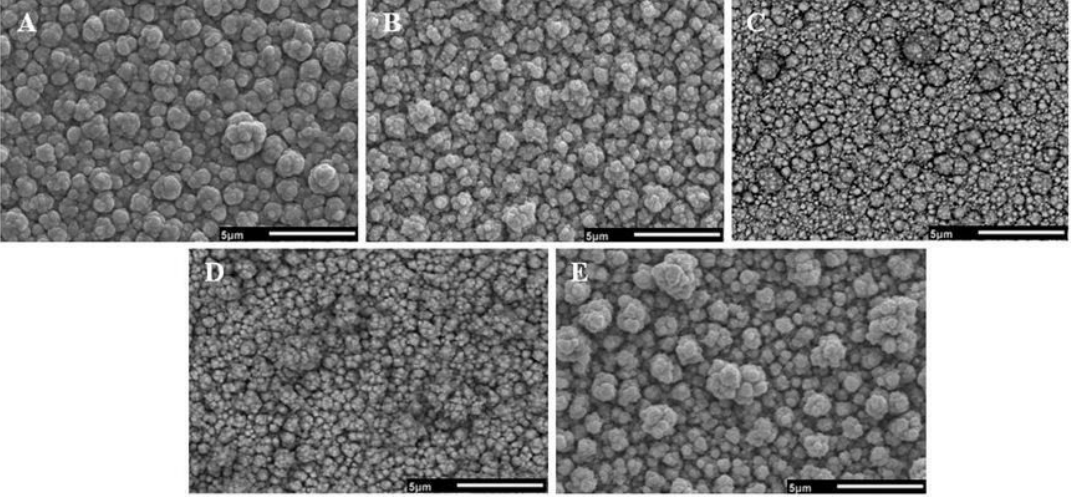
Figure 4. Surface morphology for the Cu-Sn coatings produced by SPC electrodeposition, using (A) j (B) j = 267.0 A m -2 (Experiment 3’); (C) j c (Experiment 6’). Magnification of